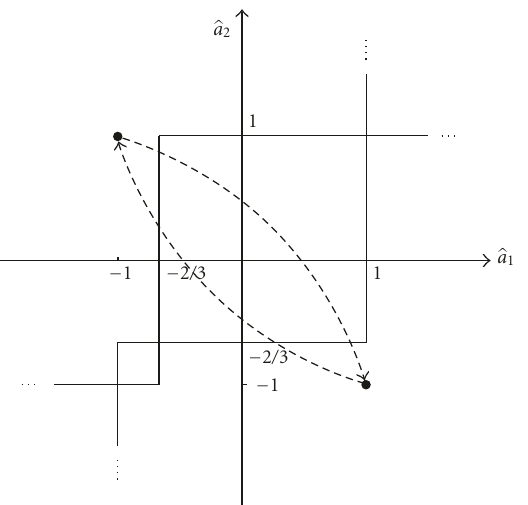
Figure 2: Analysis of a cycle of length 2 with convergence chart formed by two nested hard decision functions for BPSK and IHDIC with parallel update : in course of iterations the estimates (1, − 1) lead to ( − 1,1) which in turn results in (1, − 1) (cf. also Figure 1).